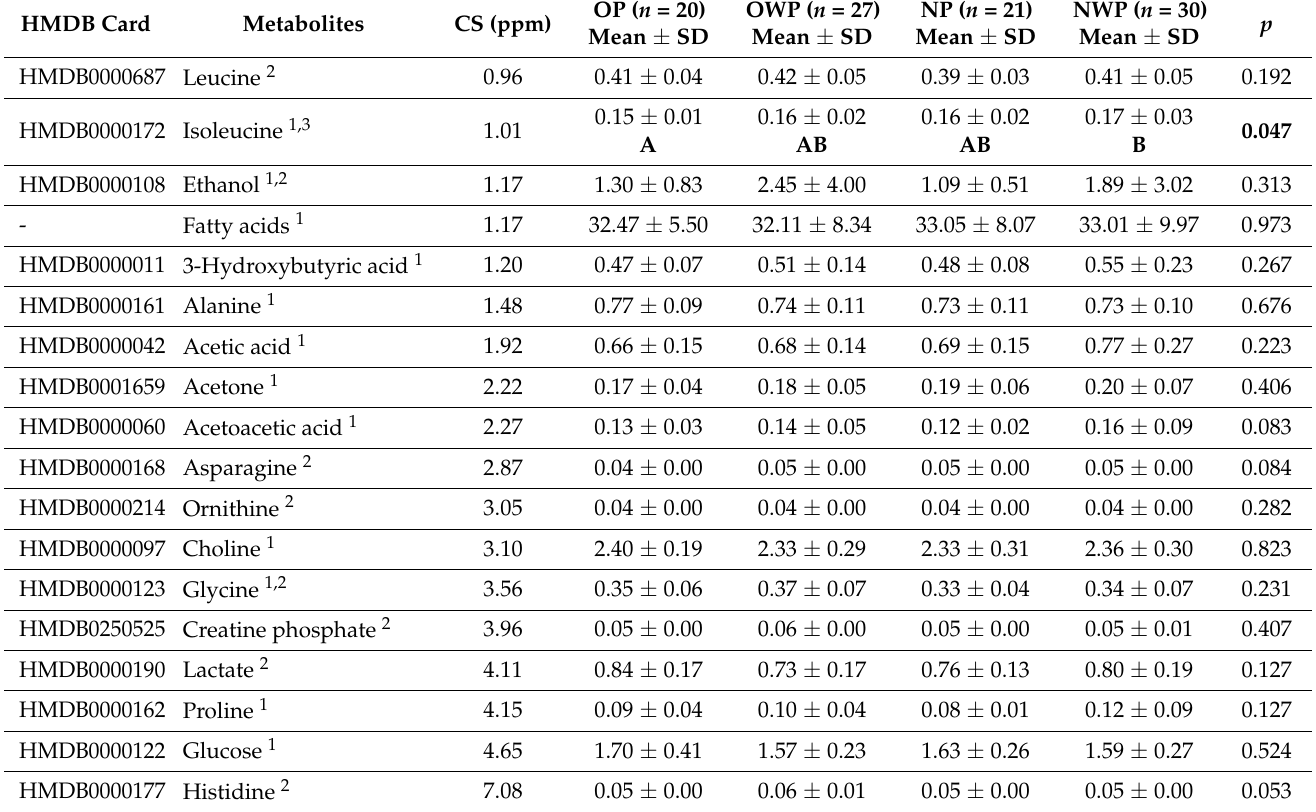
Table 2. Main plasma metabolite concentration shown as the mean, standard deviation, chemical shift (ppm), and statistical analysis from multivariate analysis using the (1) VIP scores, (2) loading factor and (3) univariate